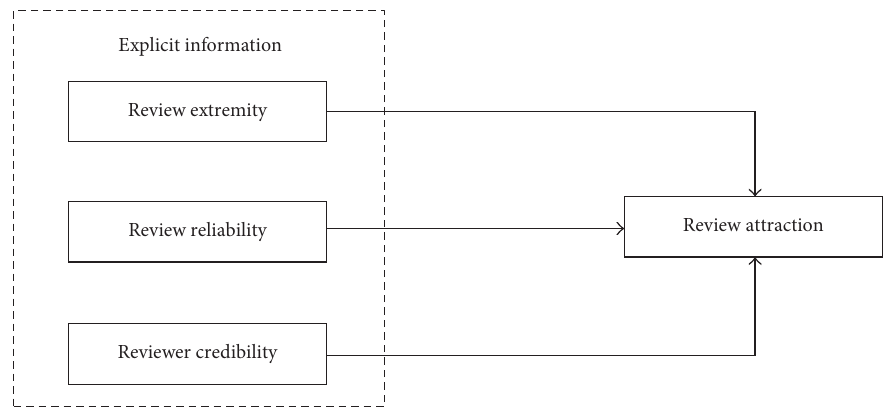
Figure 2: Conceptual framework of influencing factors of review